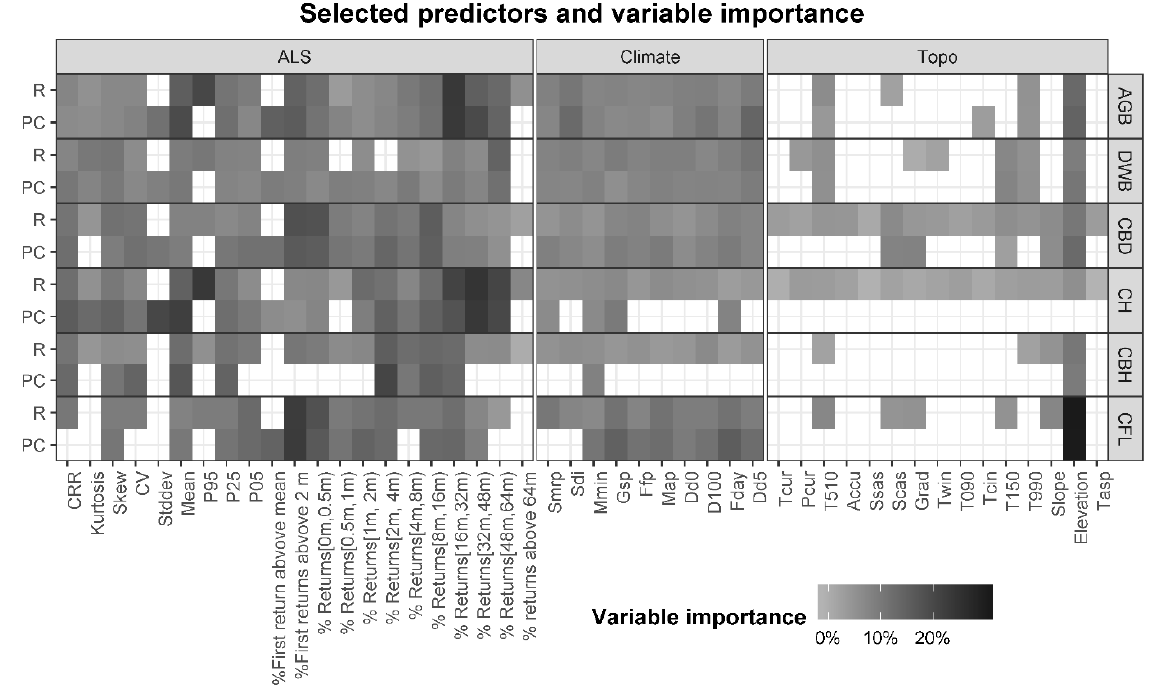
Figure A5. Predictors included in the semiparametric models and variable importance as percent reduction in mean squared error. R and PC indicate models developed with rasterized and point-cloud metrics respectively. Model response variables are: aboveground biomass (AGB), downed woody biomass (DWB), canopy bulk density (CBD), canopy height (CH), canopy base height (CBH), and canopy fuel loading (CFL). Table A7. Variance parameters for the random effects and model errors for the semiparametric models obtained for each response variable, set of ALS acquisition and source of ALS predictors. Model response variables are: aboveground biomass (AGB), downed woody biomass (DWB), canopy bulk density (CBD), canopy height (CH), canopy base height (CBH), and canopy fuel loading